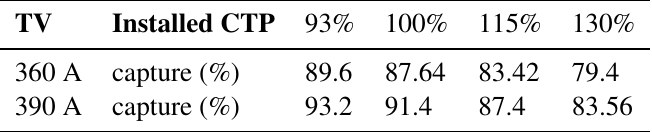
Table 11. Effect of installed CTP power on theoretical wind